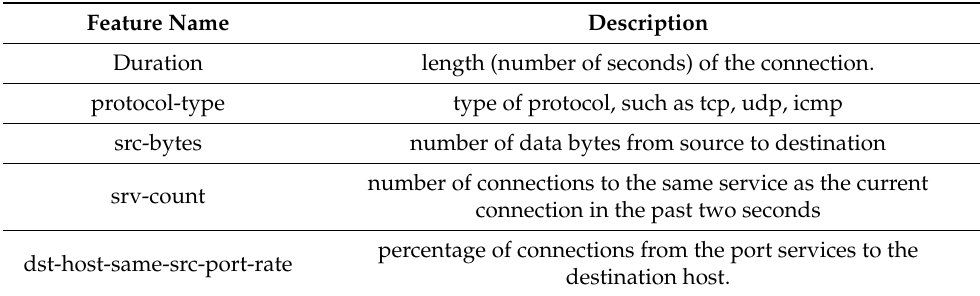
Table 4. Selected features with their